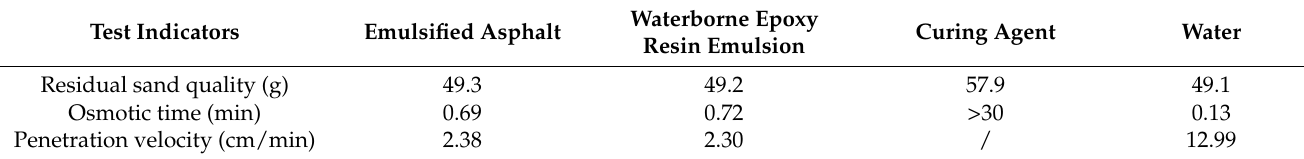
Table 4. Permeability of different tested liquids.